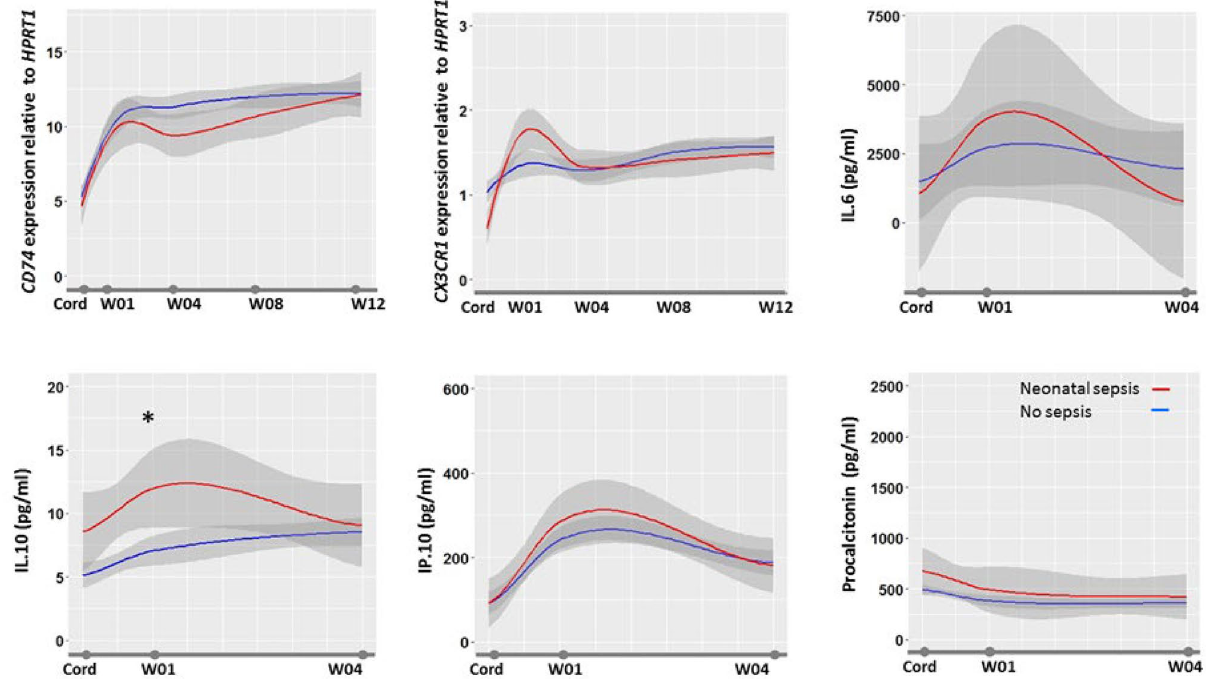
Figure 4. Biomarkers kinetics during 3 months of follow-up. The figure shows the biomarkers profile during the first 3 months of life in healthy infants with median value (in blue), 95%confidence interval (in gray), and median value in septic infants (in red). Biomarkers were measured at delivery in cord blood (Cord) and at first, 4, 8 and 12 weeks in peripheral blood. Data are expressed as medians. Anova test was used to compare biomarkers